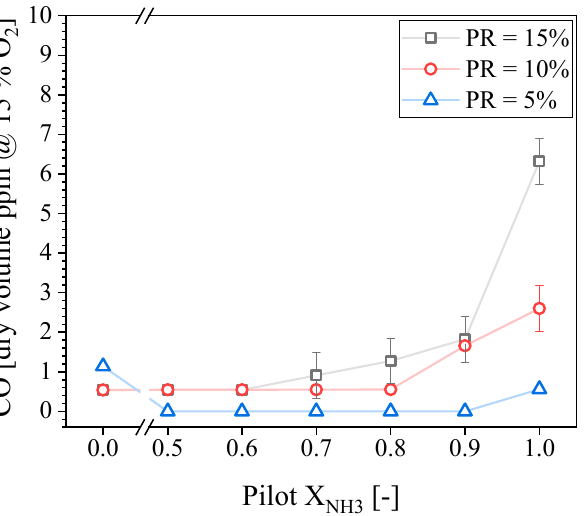
Figure 9. Measured CO concentration in the exhaust gases as a function of the pilot NH 3 for different PRs.